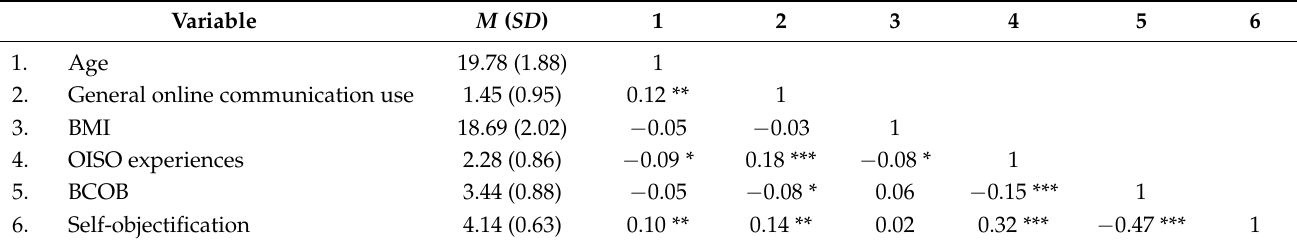
Table 1. Descriptive statistics and correlations among study